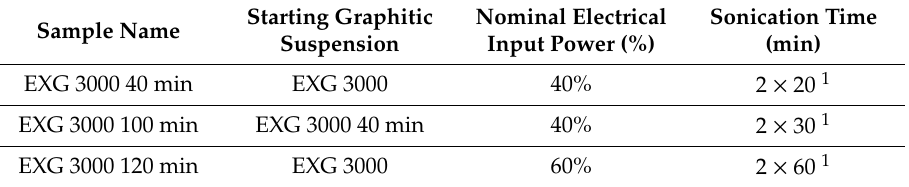
Table 1. Conditions applied for the ultrasonication of the graphene ink EXG 3000. Sample